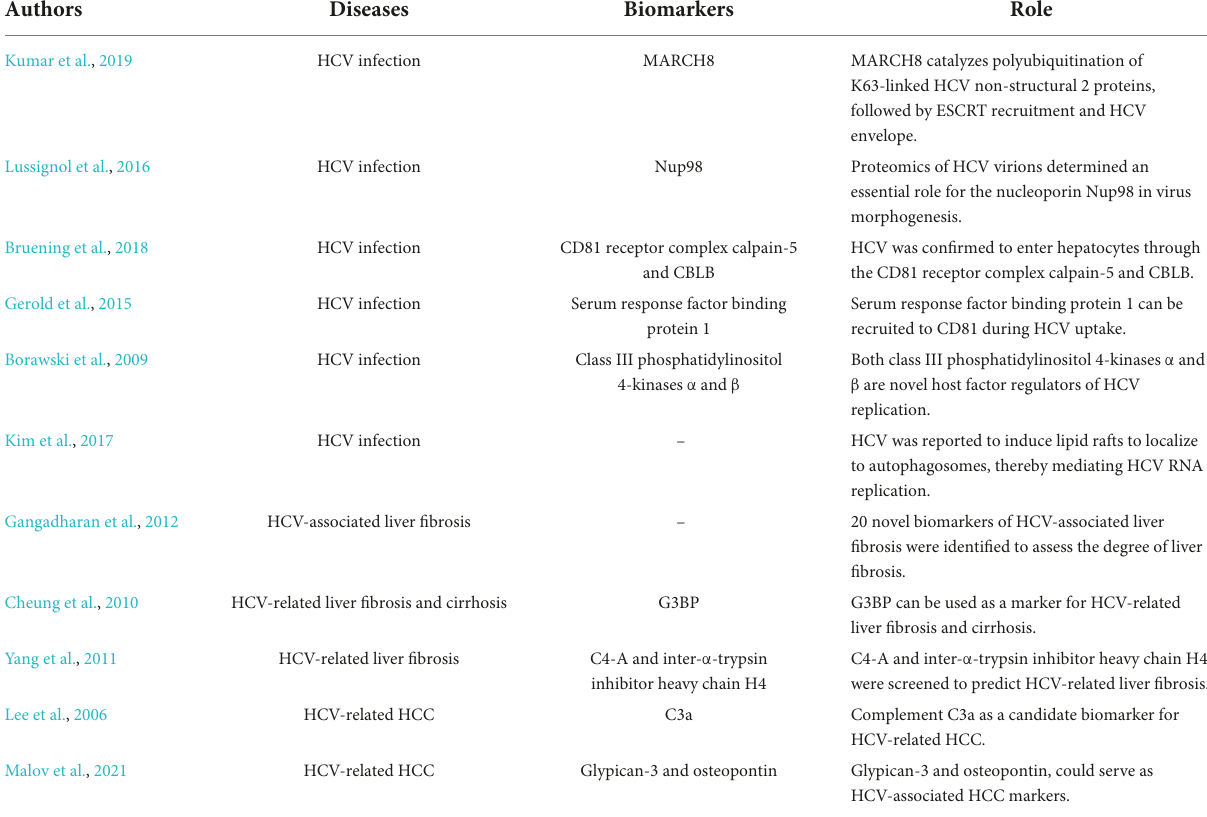
TABLE 2 The applications of proteomics in hepatitis C and related